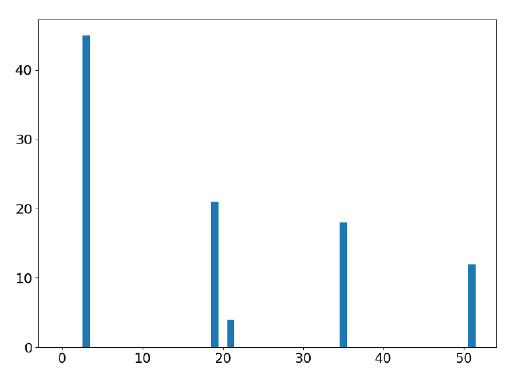
Figure 8 . # of n -generation models w.r.t. n H for search (II) with h 1 ; 1 = 3. The axes are the same as (cid:12)gure 7.